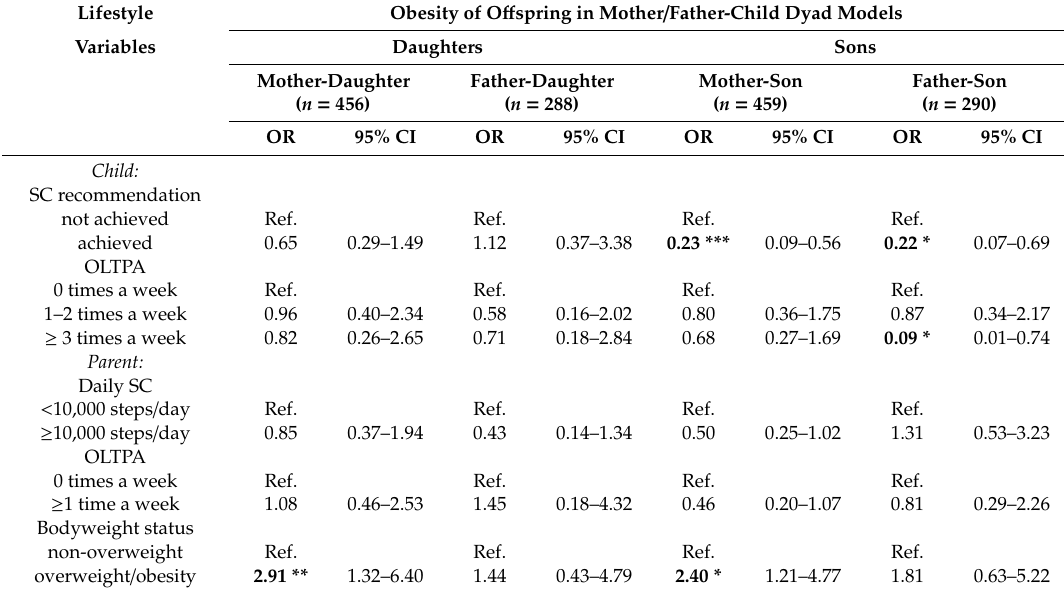
Legend: The binary logistic regression models presented in Table 2 were adjusted for the age category of o ff spring; SC—step counts (the daily step count recommendation represents ≥ 13,000 / ≥ 11,000 steps / day for